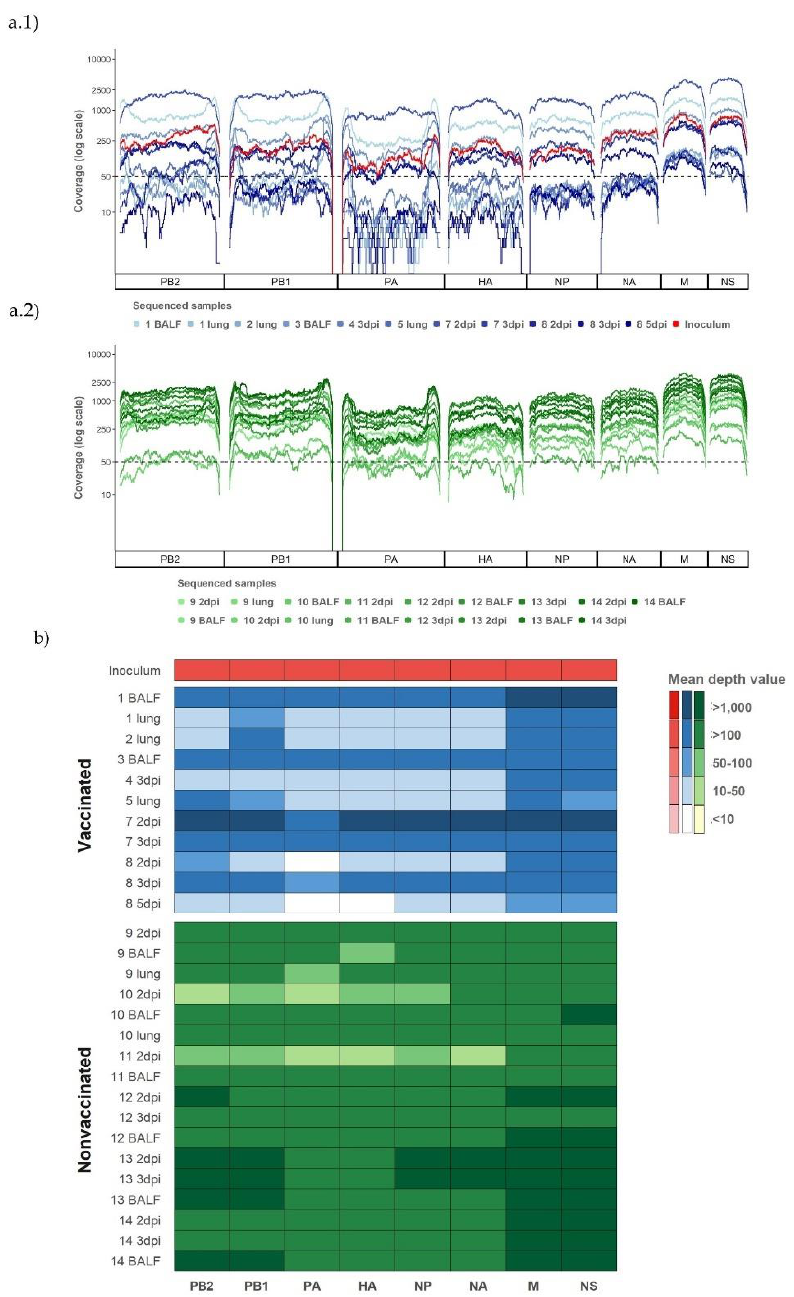
Figure 2. Coverage per genomic segment and sample from both experimental groups and the challenge inoculum. ( a ) Representation of the coverage of Illumina sequencing reads mapped against A/Swine/Spain/01/2010(H1N1) used for challenge. ( a1 ) Sequencing profiles of sequenced samples from vaccinated animals and inoculum plotted in different tones of blue and red, respectively. ( a2 ) Sequencing profile of sequenced samples from nonvaccinated animals plotted in different tones of green. ( b ) Representation of the mean read coverage heat map per segment. The identification of the animal from which the samples come and the kind of collected sample are specified on the figures, with the nasal swab collected at the indicated day being the samples with dpi.